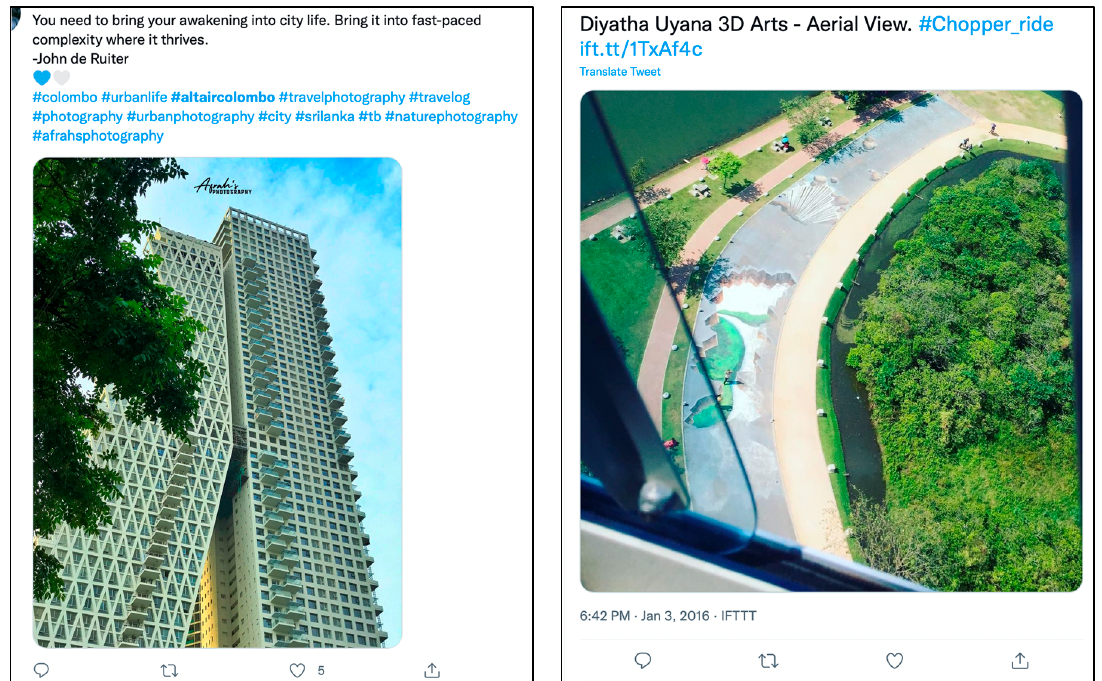
Figure 6. Exemplary tweets posted sharing positive sentiments about ARC and DP.